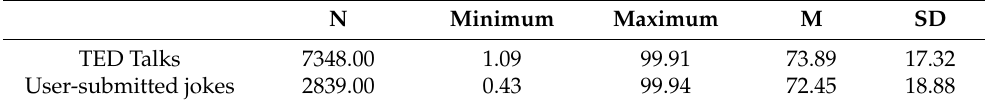
Table 2. Summary of statistics for the readability scores using the Flesch reading ease